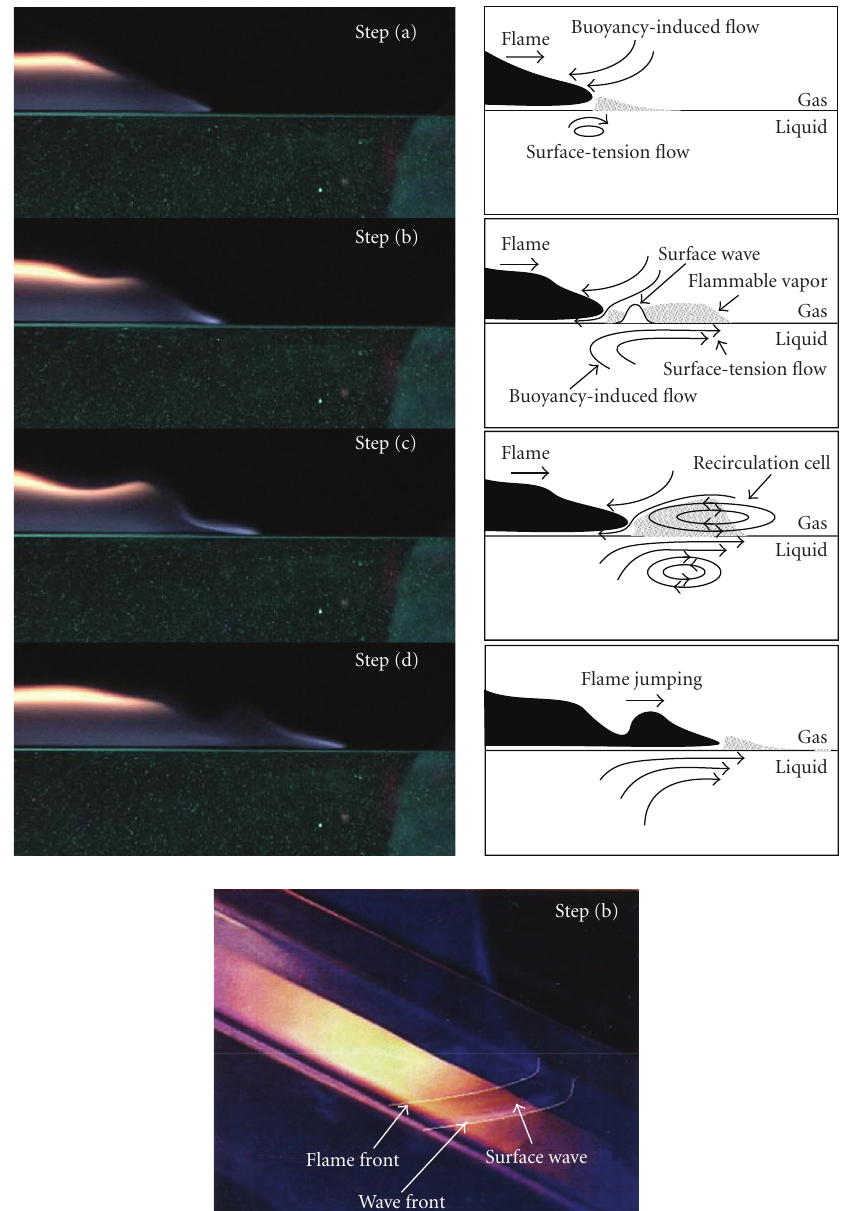
Figure 1: Step in a single cycle of pulsating flame spread and surface wave in step (b)